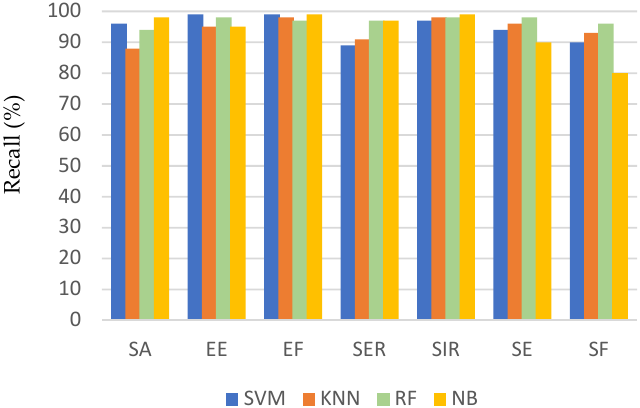
Figure 6. Recall for each activity using different classification algorithms.